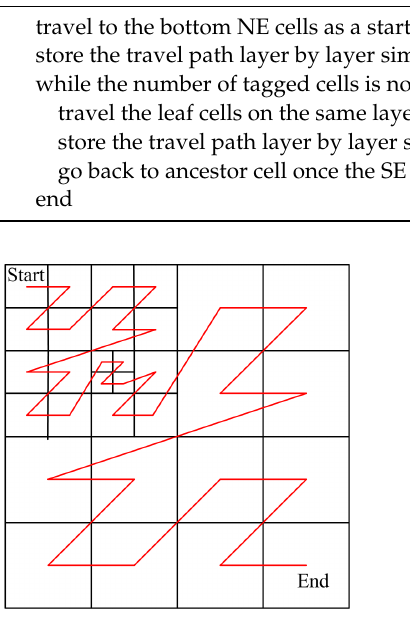
Figure 7. Z-order filling curve.